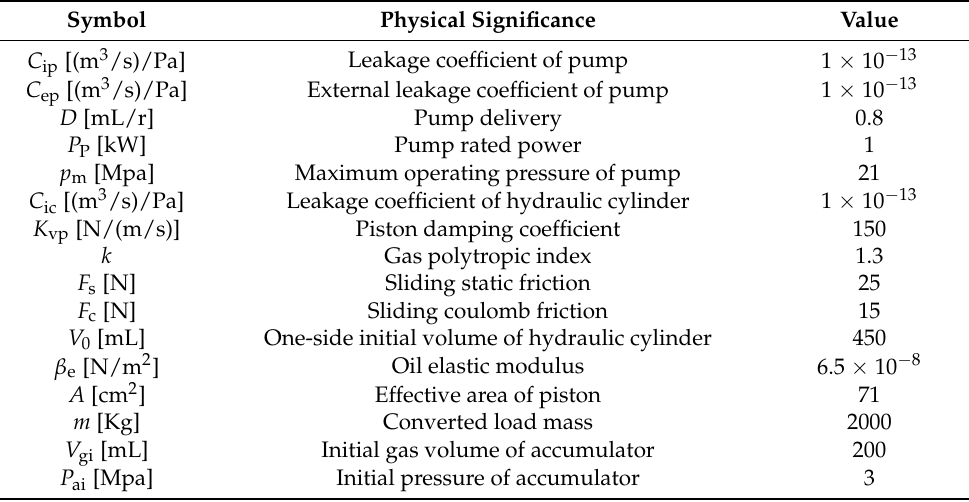
Table 5. Main parameters of the experimental